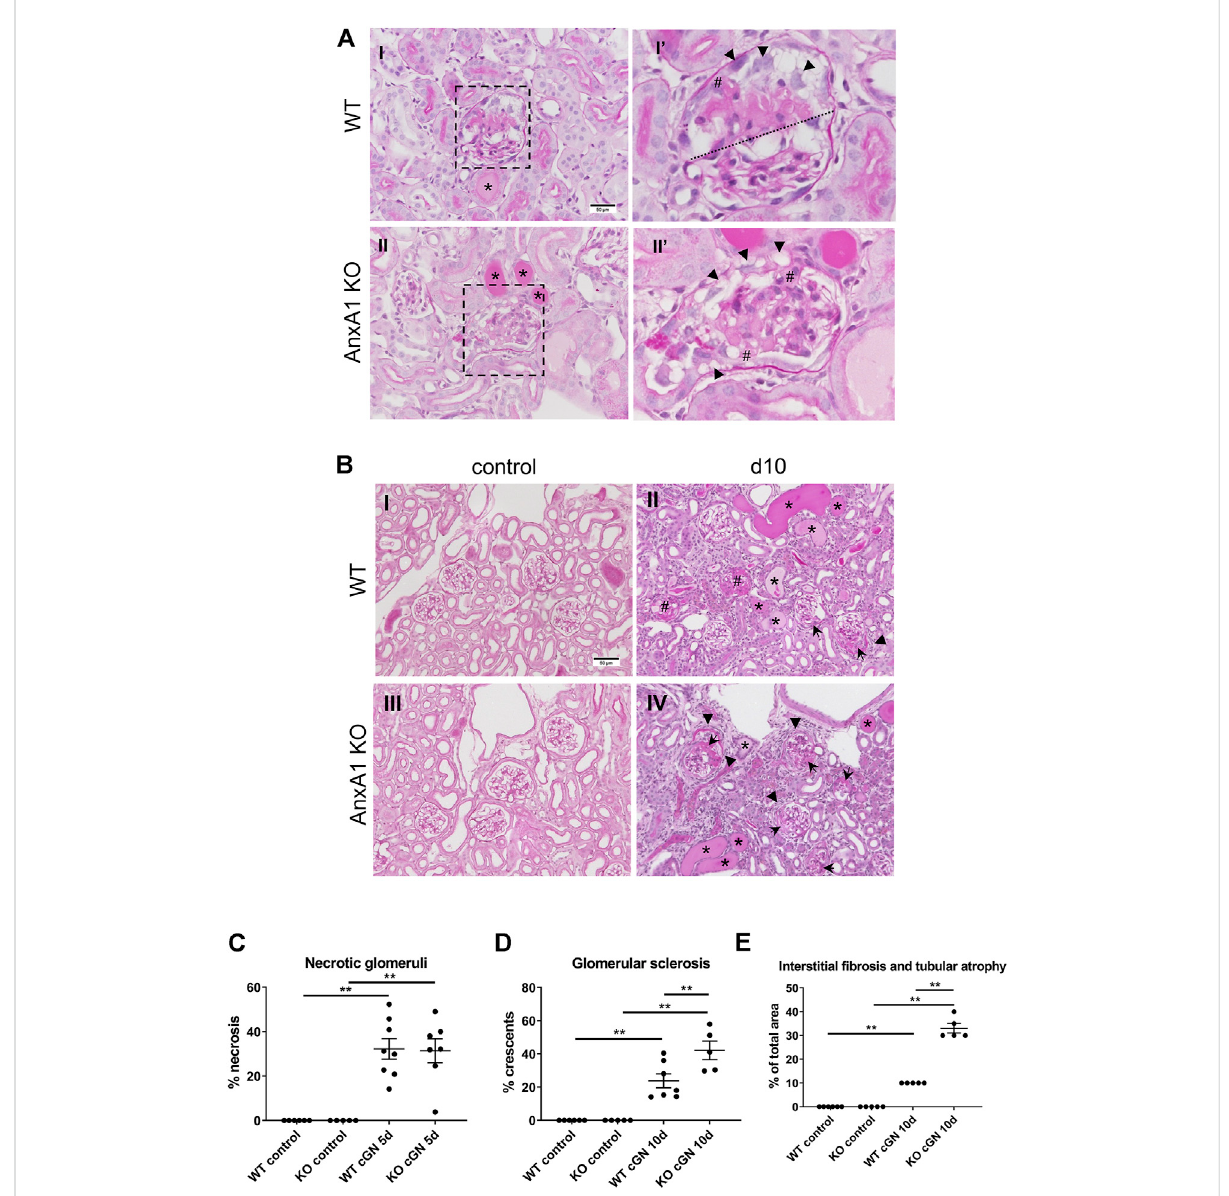
FIGURE 3 De fi ciencyofannexinA1hasnoeffectatd5butaggravatesrenaldamageatd10. (A) RepresentativemicrographsofPAS-stainedkidneysections from wildtype (WT; I,I ′ ) and annexin A1 (AnxA1)-de fi cient mice (KO; II,II ′ ) at d5 after induction of crescentic glomerulonephritis (cGN). Low power micrographs(I,II) showglomeruliwithsignsofnecrosis, tubularpro fi les fi lledwith proteincasts(*)and mildfocalinterstitialexpansion.Magni fi cation oftheglomerularpro fi lesboxedinIandII(I ′ ,II ′ )showsegmental(abovedottedlineinI ′ )andglobalnecrosis(II ′ )aswellasseveraltiplesionswith attachment of the glomerular tuft to the Bowman capsule (#). Parietal epithelial cells show typical signs of activation with enlarged nuclei and polygonal cell bodies (arrowheads in I ′ and II ′ ). Scale bar = 50 µm in I + II. (B) Representative micrographs of PAS-stained kidney sections from wildtype (WT; I,II) and annexin A1 (AnxA1)-de fi cient mice (KO; III,IV) at d10 after injection of normal sheep serum (control; I,III) or induction of cGN (II,IV). Control mice of both genotypes show normal renal morphology. At d10 after cGN induction, glomeruli in mice of both genotypes show morphological hallmarks of extracapillary proliferative glomerulonephritis with crescent formation (arrowheads), global sclerosis (#), and periglomerular fi brosis(arrows).Theinterstitialspaceisexpandedwithanincreasednumberofleukocytesand fi broblasts.Numeroustubularpro fi les are fi lledwithproteincasts(*).Scalebar=50 µminI-IV. (C) Quanti fi cationofglomerularpro fi leswithmorphologicalsignsofnecrosisatd5aftercGN induction. (D) Quanti fi cation of glomerular pro fi les with crescents or global sclerosis at d10 after cGN induction. (E) Quanti fi cation of areas with tubular atrophy and interstitial fi brosis at d10 after cGN induction. Dots represent values from individual animals; horizontal lines indicate mean values and error bars represent the SEM. Statistical signi fi cance of changes was calculated using one-way ANOVA; n = 5 – 8 per